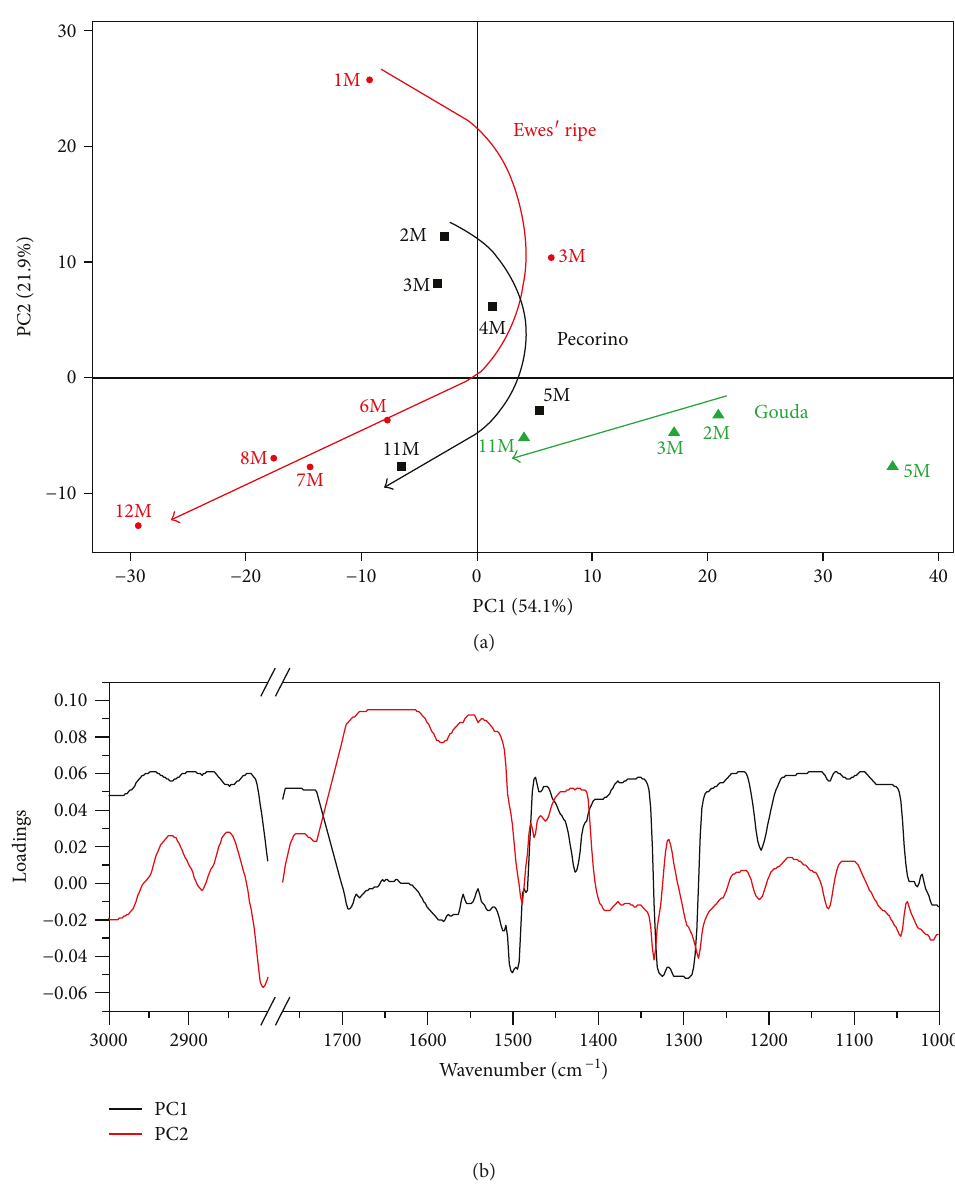
Figure 5: Principal component analysis of the selected wavelength spectra of the 15 samples of Pecorino ( ■ ), Gouda ( ▲ ), and ewes ’ ripe ( ● ) varieties of cheese. (a) Score plot. (b) Loading plot. M: